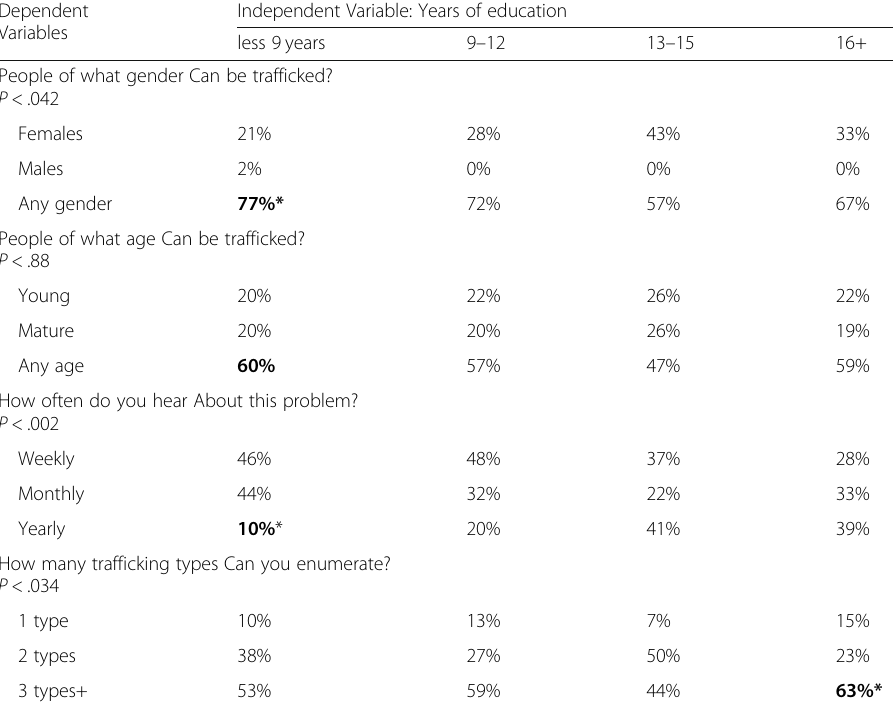
Table 2 The level of education and knowledge about human trafficking Dependent Independent Variable: Years of education Variables less 9 years 9 – 12 13 – 15